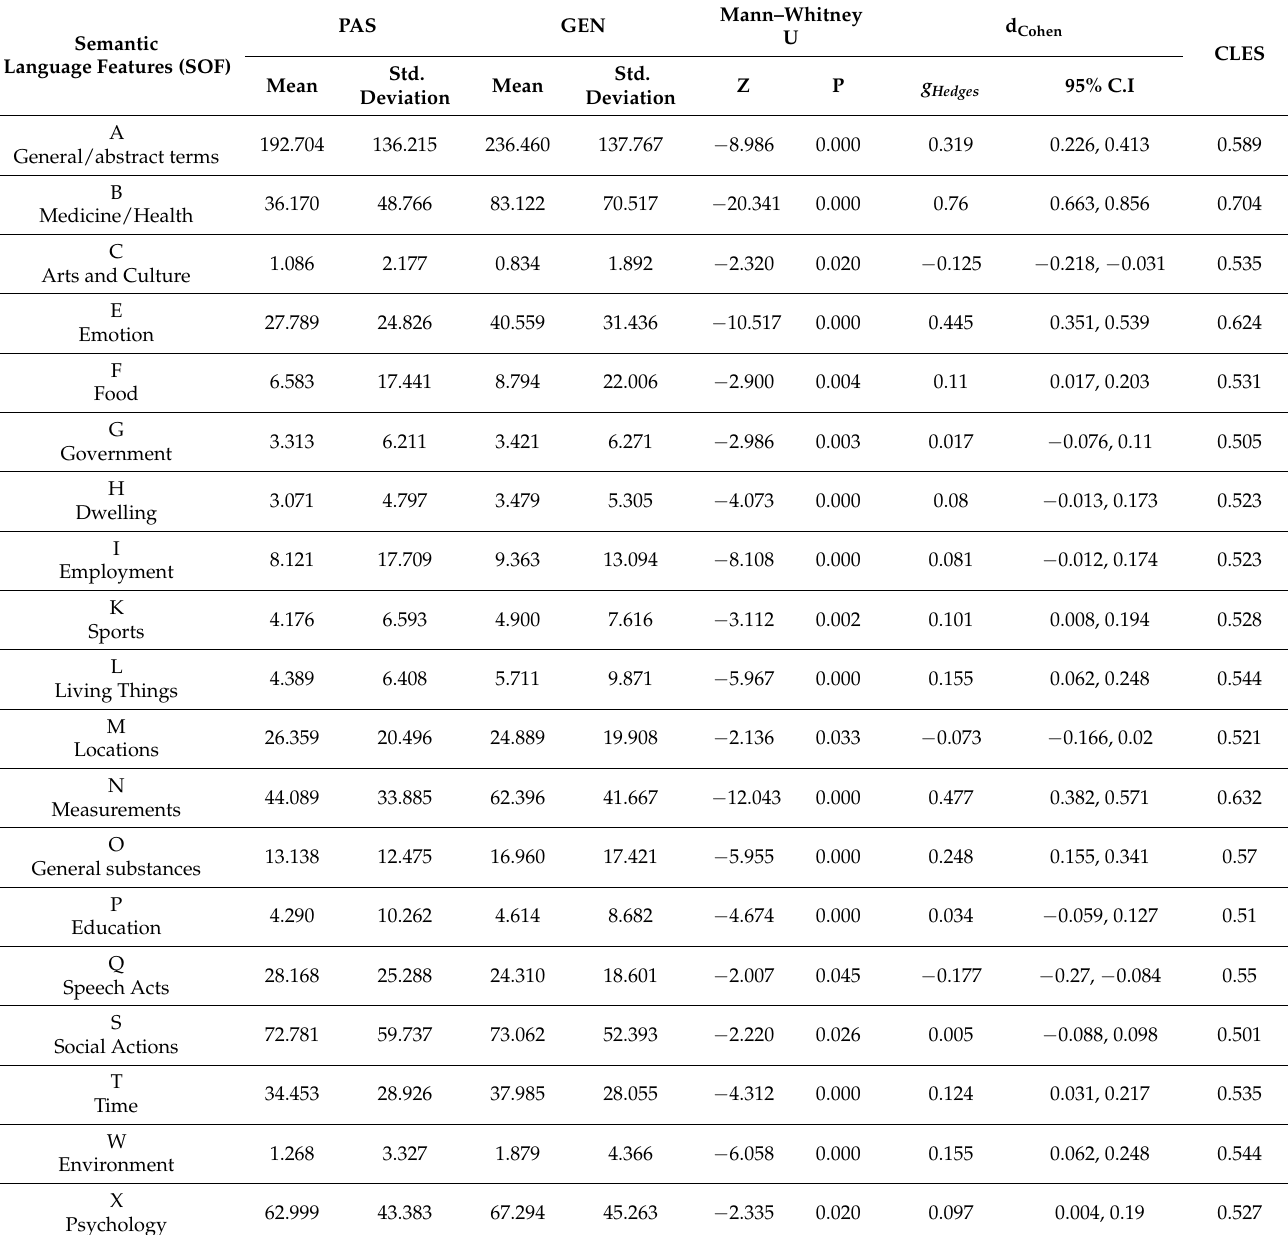
Table 2. Mann–Whitney U test, Effect Sizes ( d CoheN ) and CLES of semantic features